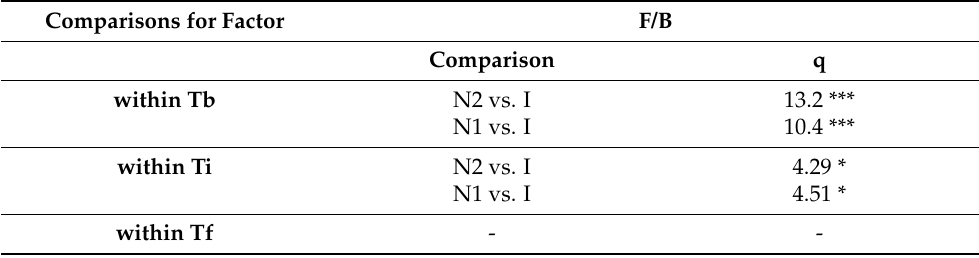
Table 5. q values of Tukey HSD tests for soil types x time interactions in pair comparisons according to F/B ratios. Asterisks indicate significant differences among soil sampling areas (*** p < 0.001, * p <